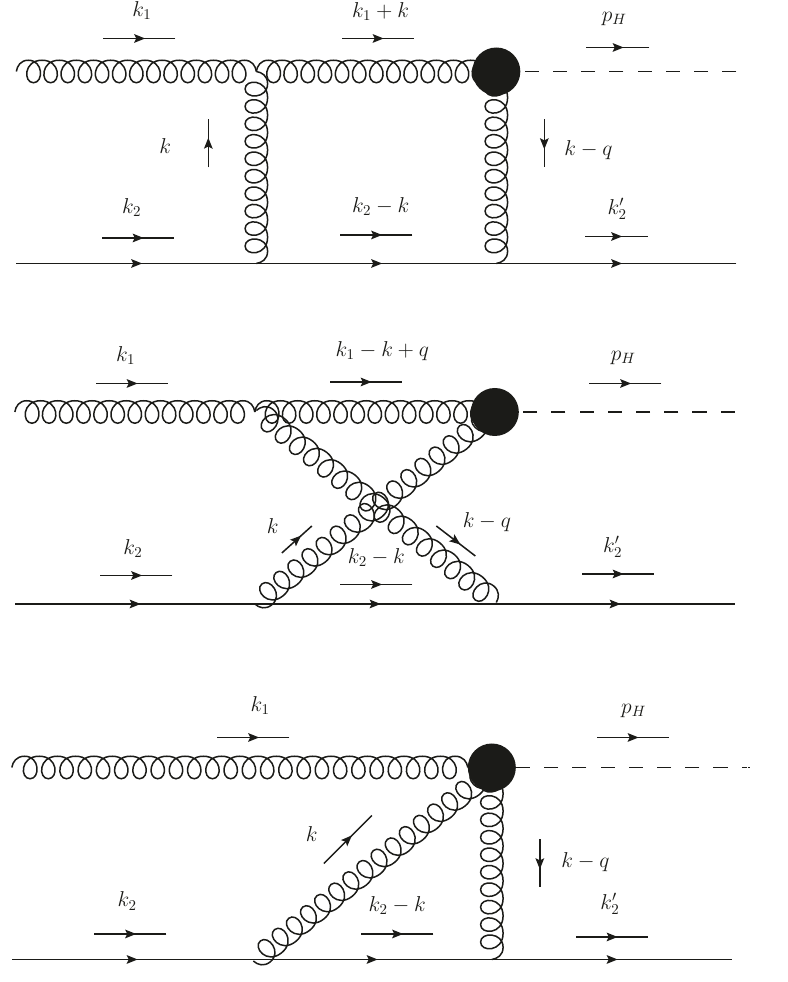
Figure 11 . Feynman diagrams contributing to the gR → gH